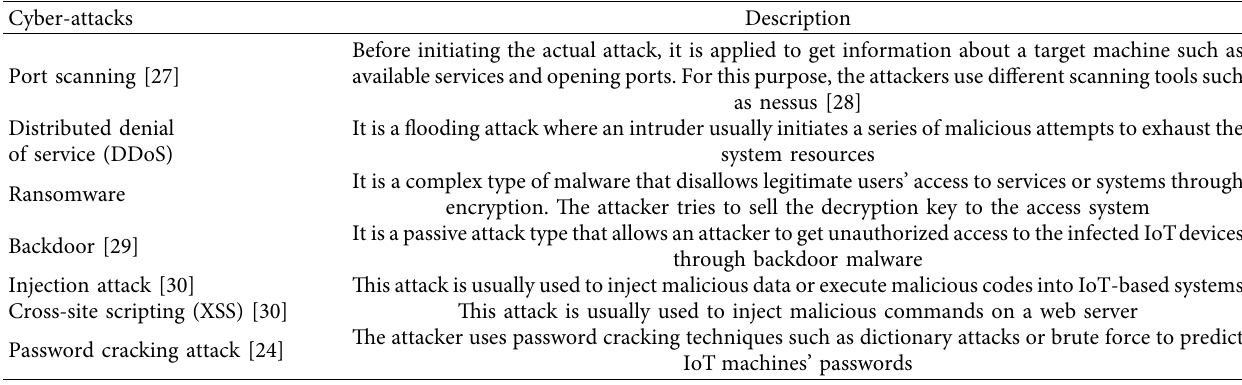
Figure 5: (a) Attack distribution in weather dataset; (b) attack distribution in thermostat dataset; (c) attack distribution in GPS tracker dataset; (d) attack distribution in fridge dataset; (e) attack distribution in garage door dataset; (f) attack distribution in motion light; (g) attack distribution in Modbus. Table 1: Cyber-attacks description.